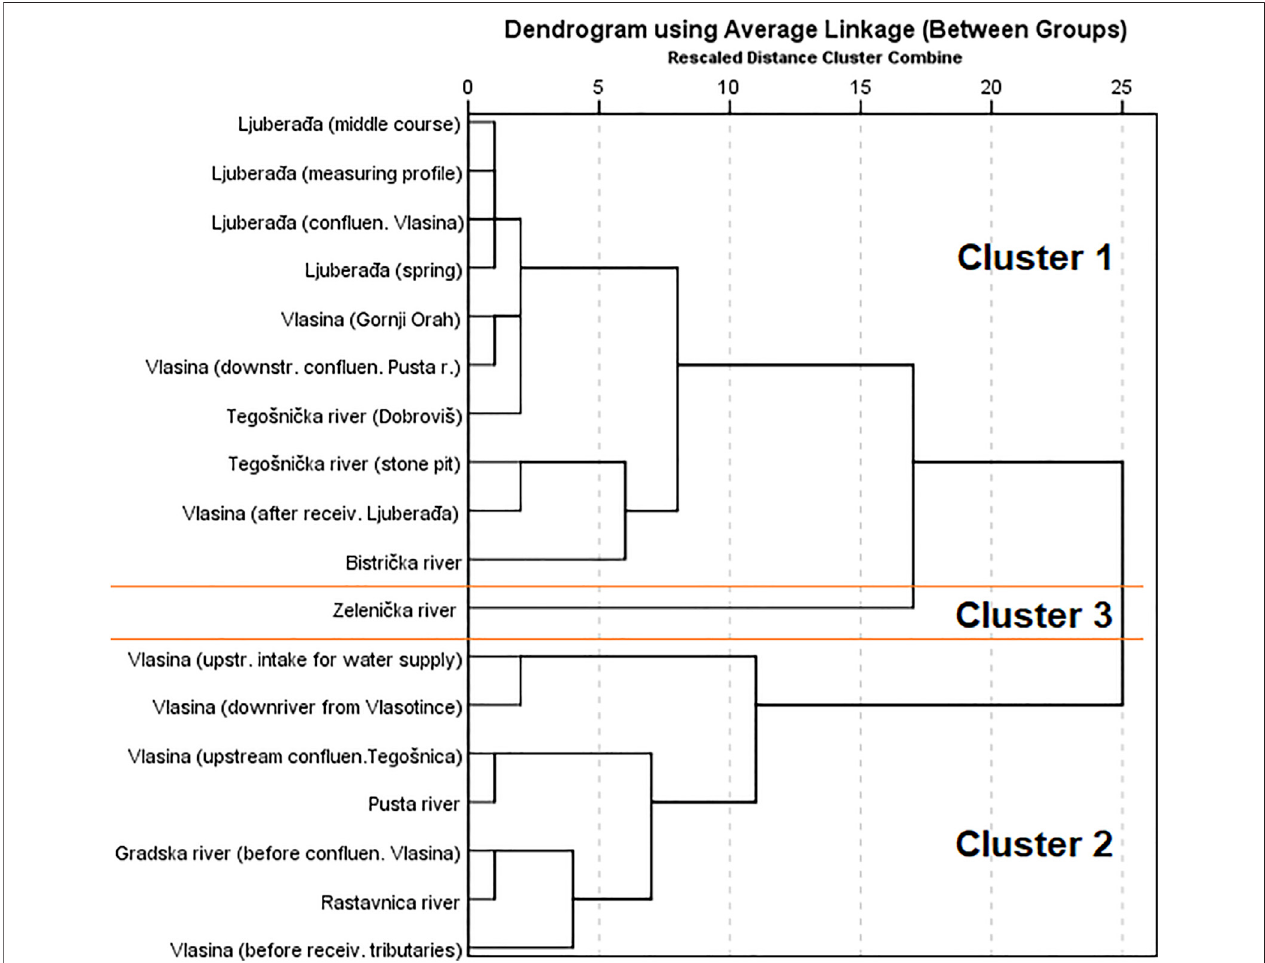
FIGURE 4 | CA (Q mode) for trace elements in river